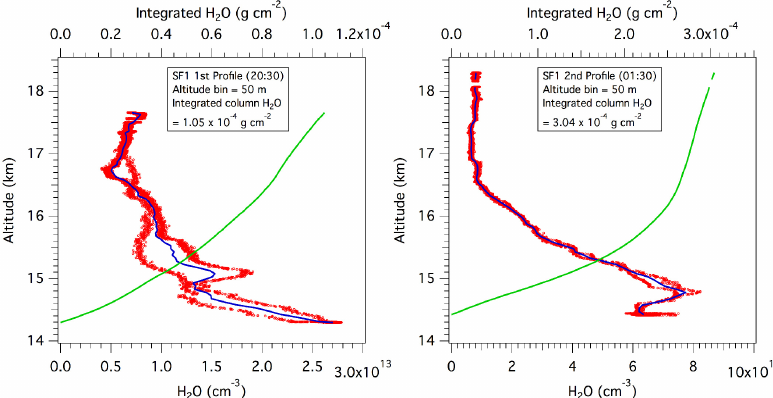
Figure 5. Water vapor number density profiles from the NOAA water instrument. The red points correspond to the in situ water vapor number densities during the descent and ascent for the two profiles. The blue line is the mean of the ascent and descent number densities. The green line is the integrated water vapor amounts (scale at the top of the plot). Note the large difference in the horizontal axis ranges and the integrated water vapor amounts between the two